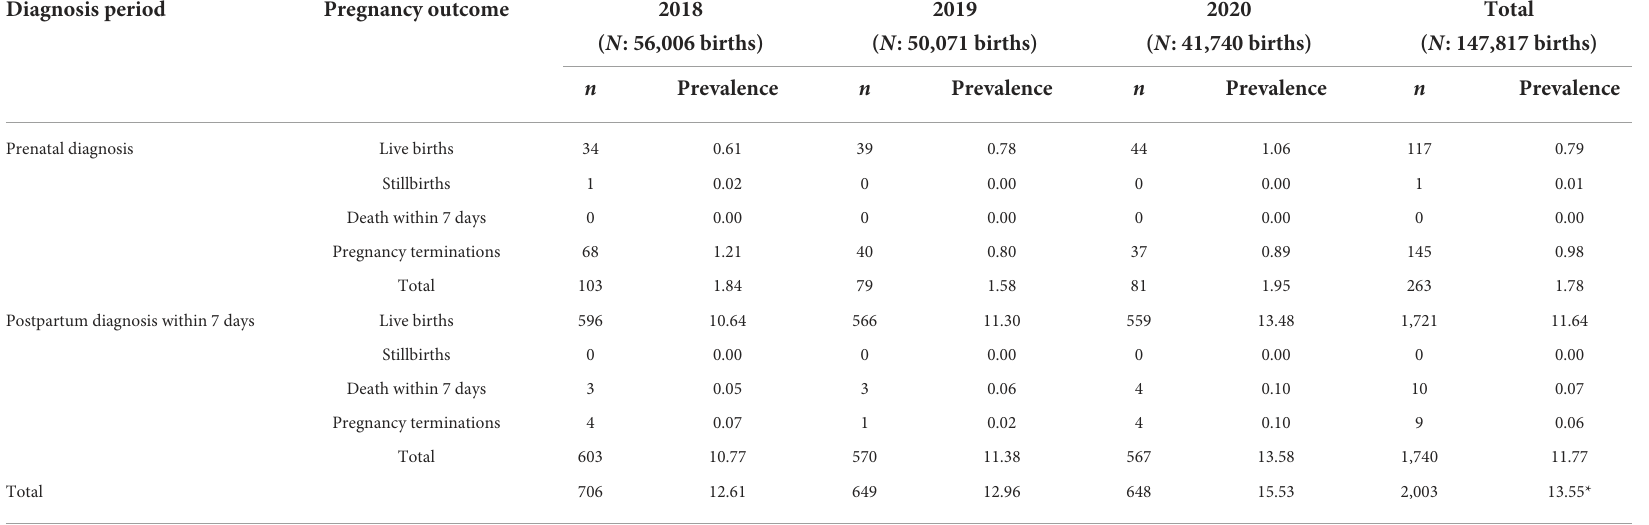
TABLE 1 Birth defects counts and prevalence (per 1,000 births) stratified by pregnancy outcome at different two diagnosis periods in Guilin,